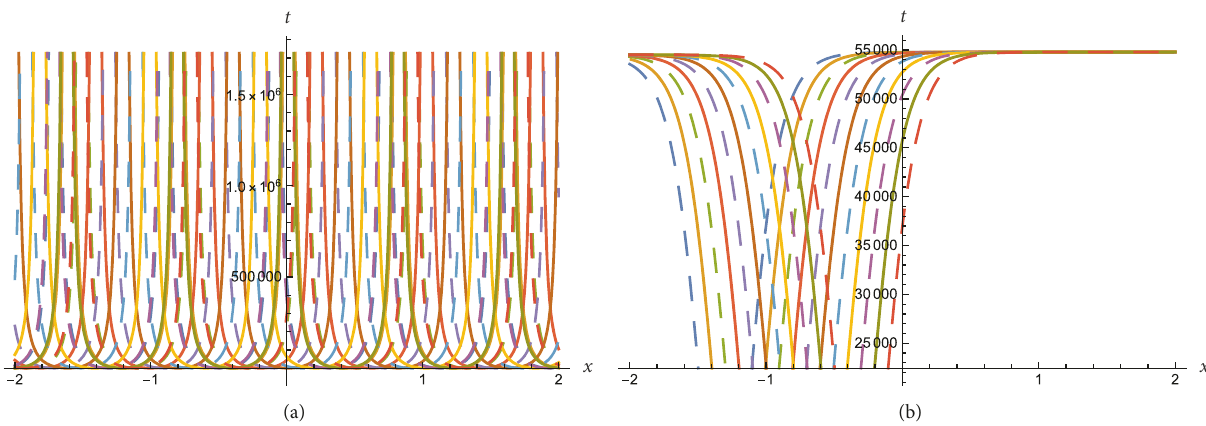
Figure 3: Plot of the exact traveling wave solutions of (a) periodic solitary wave solution (23) with parameters 𝑎 1 = 1;𝛼 = 0.6; 𝑙 0 = 0.7;𝑙 4 = 9;𝑙 = 20; 𝜅 = 0.7; 𝑐 = 0.1;𝑦 = 0.8 ; (b) dark solitary wave solution (25) plotted at 𝑎 2 0.8